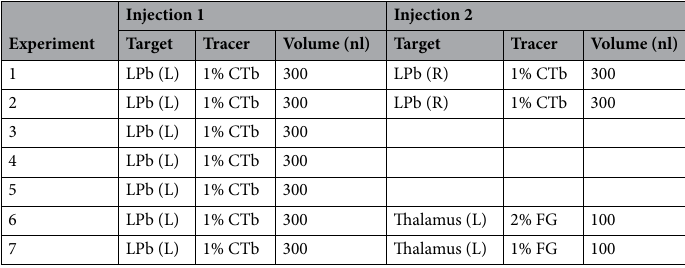
Table 1. Injection sites in mice used for anatomical